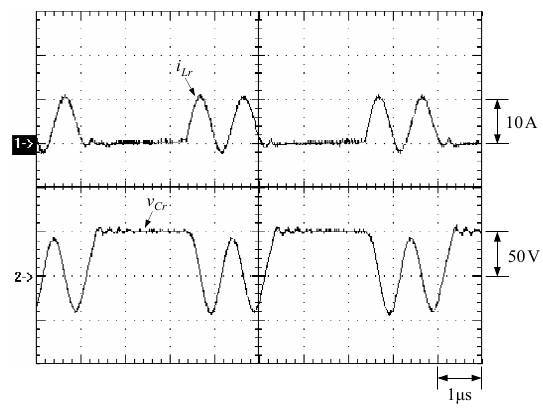
Figure 14. Waveforms relevant to S 2 : (1) v g 2 ; (2) v ds 2 ; (3) i ds 2 .